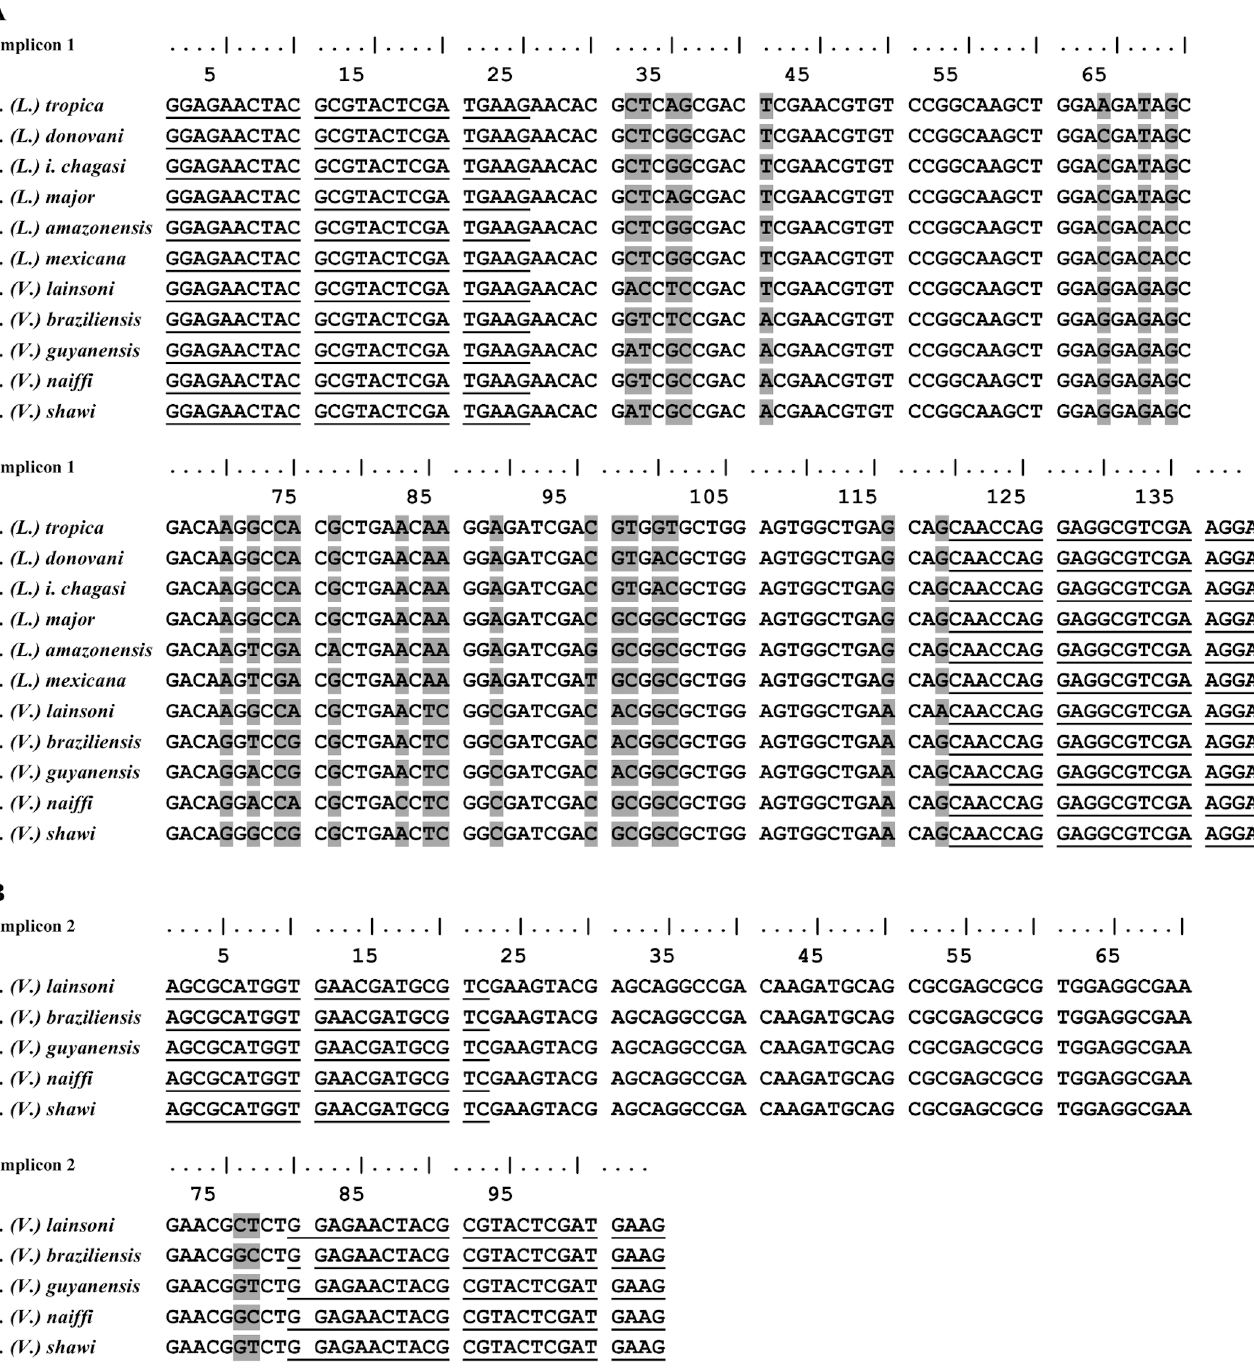
Fig 1. Nucleotide sequence of hsp70 amplicons and primer localization. Alignment of the nucleotide sequence of amplicon 1 (A) and amplicon 2 (B) of each Leishmania species used in the HRM analysis. The underlined sequences indicate the position of the primers used in real-time PCR assays; the grey boxed nucleotides represent the variable regions found among reference strains of Leishmania